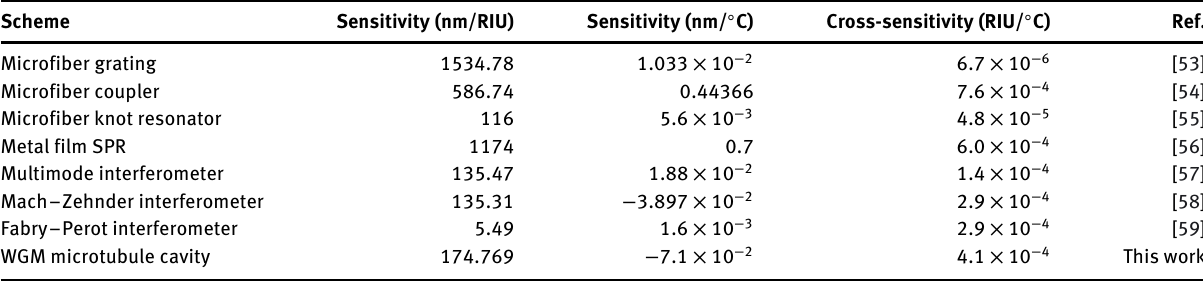
Table 1: A comparison between the proposed WGM microtubule cavity and the optical fiber sensors based on evanescent field.